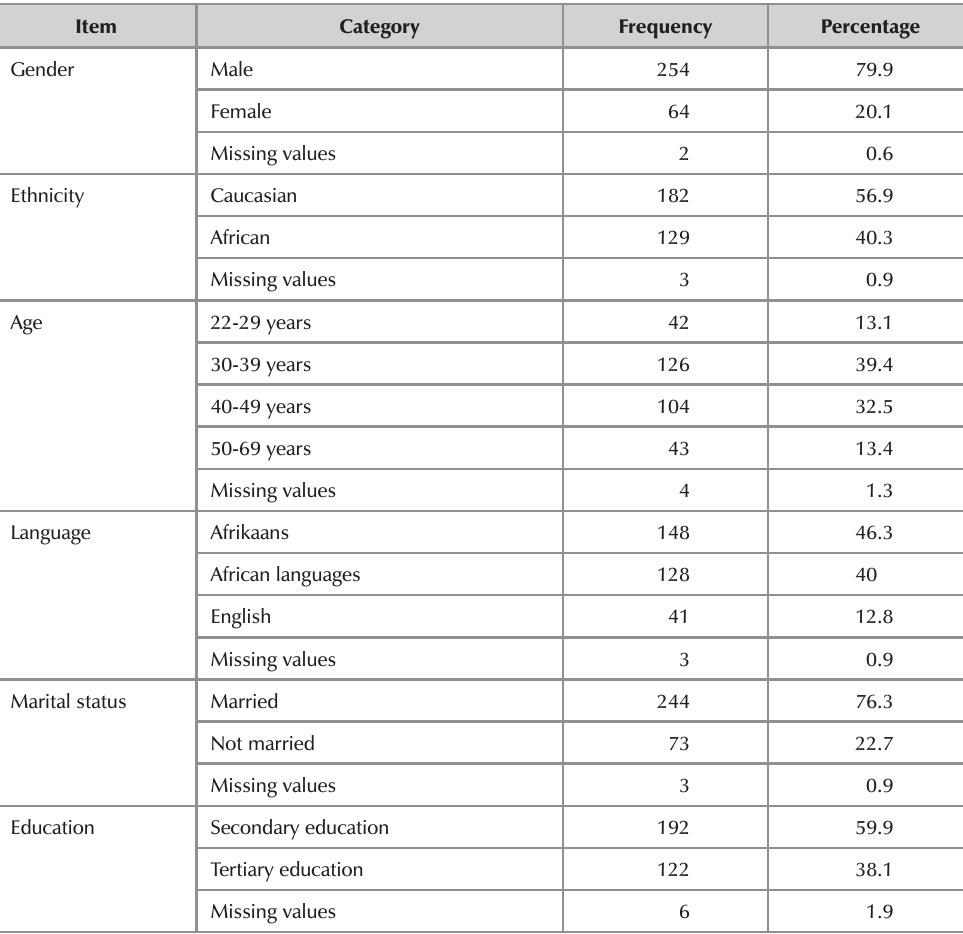
Characteristics of the